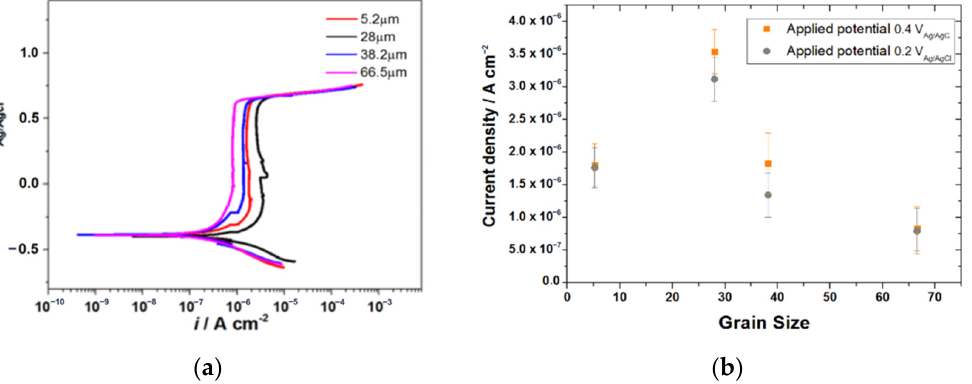
Figure 7. ( a ) Potentiodynamic polarization curves in 0.1 M NaOH solution ( b ) Current density values measured at 0.2 and 0.4 V as a function of PAGS.